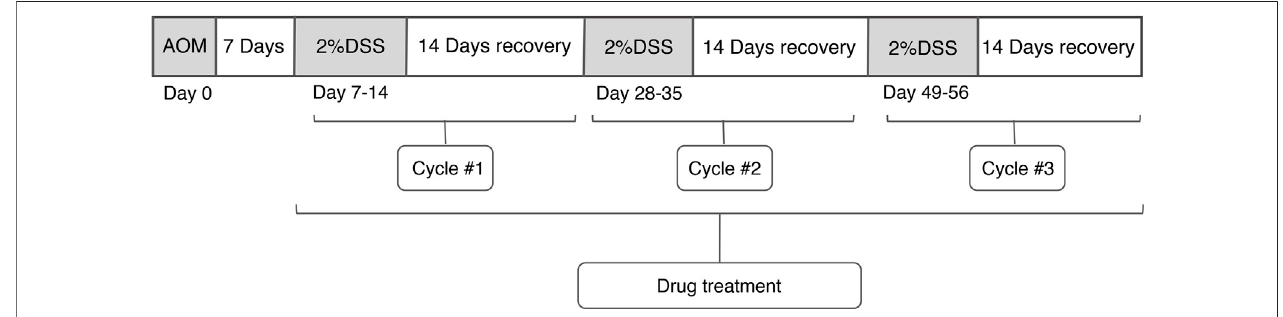
FIGURE 1 | AOM/DSS model construction